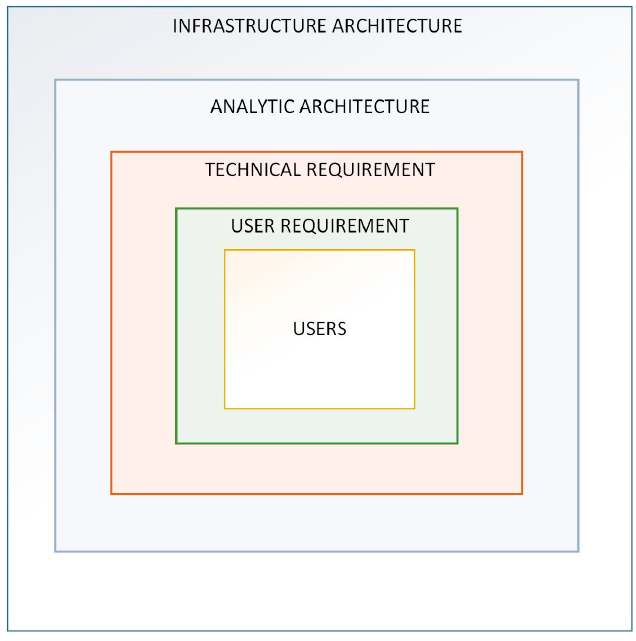
Figure 1. Technical feasibility approach.